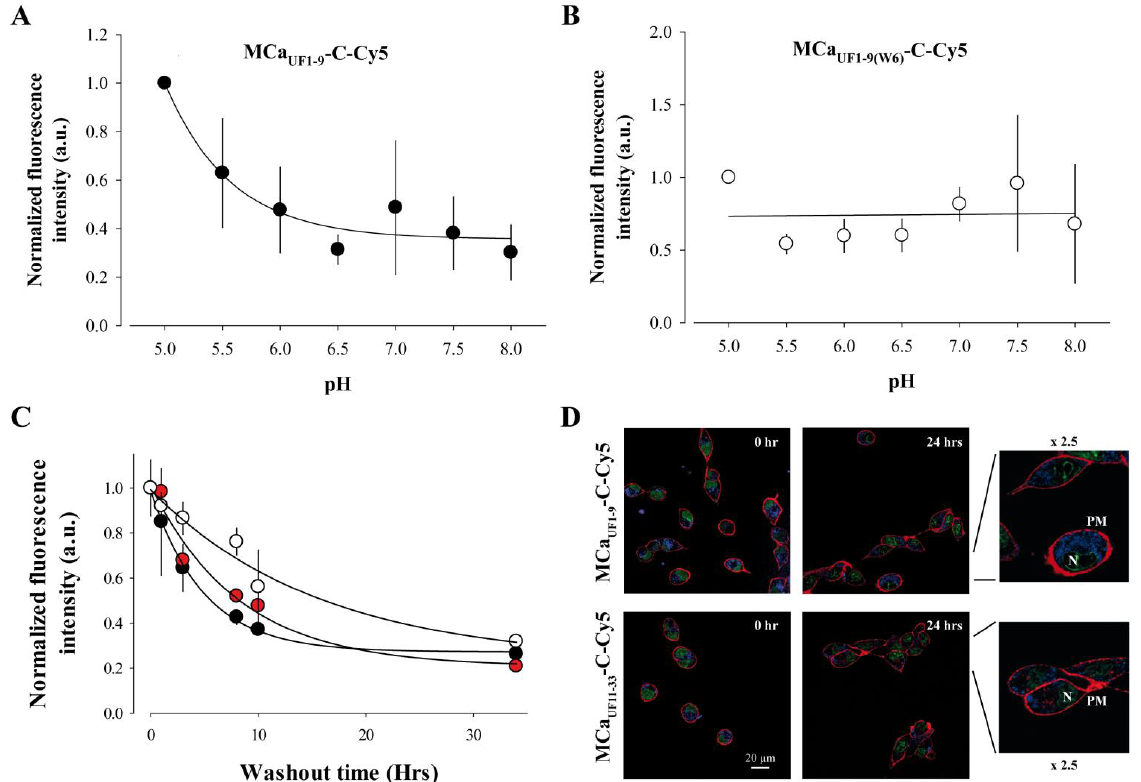
Figure 5 . pH-dependence and persistence of the cell penetration of MCa -C-Cy5. ( A ) UF1-9 Effect of extracellular pH variation on the cell penetration efficacy of 1 µM MCa -C-Cy5 UF1-9 in F98 cells (2 h incubation). Mean of n = 3 experiments ± S.D. Mean FACS results were normalized before averaging. Data were fitted by a decreasing exponential of the type y = y + a.e −bx where y = 0.36 ± 0.05, a = 0.64 ± 0.09 and b = 1.76 ± 0.61. ( B ) Effect of 0 0 extracellular pH variation on the cell penetration of 1 µM MCa (W6)-C-Cy5 in F98 UF1-9 cells (2 h incubation). The pH-insensitive Trp 6 replaces the pH-sensitive His 6 in this mutant peptide. ( C ) Persistence of the fluorescence signal in F98 cells preincubated 2 h with 1 µM MCa -C-Cy5 (net charge 0 if His 6 is unprotonated, black symbol), the UF1-9 positively charged MCa -C-Cy5 (net charge +7, red symbol) or the mildly charged UF11-33 Had -C-Cy5 peptide (net charge +2 if His 8 is unprotonated, white symbol). FACS UF3-11 results were normalized to 1 at t=0 min at the start of the washout of the CPP. Data were fitted with a decreasing exponential function with 1/  = 0.20 ± 0.01 h −1 (MCa -C-Cy5), UF1-9 0.12 ± 0.03 h −1 (MCa -C-Cy5) et 0.06 ± 0.02 h −1 (Had -C-Cy5), where  is the UF11-33 UF3-11 time constant of the decrease in the mean cell fluorescence level. The non-decreasing fraction of fluorescence was equal to 0.27 ± 0.14 (MCa -C-Cy5), 0.21 ± 0.07 (MCa -C-Cy5) UF1-9 UF11-33 and 0.23 ± 0.13 (Had -C-Cy5). ( D ) Corresponding confocal images illustrating that the UF3-11 intracellular distribution of the peptides did not change with time. The 2.5-fold image enhancement also shows a close to complete lack of nucleus invasion by the peptides. The images also show that the two peptides do not differ in the type of intracellular distribution 3.5 h after washout of the extracellular